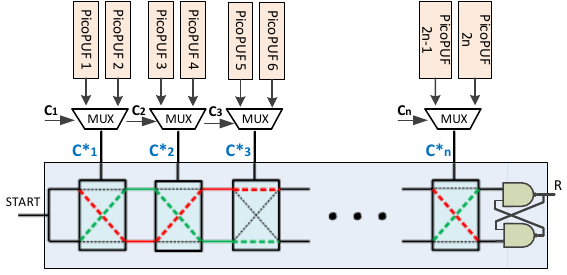
Figure 4. The proposed MMPUF design with